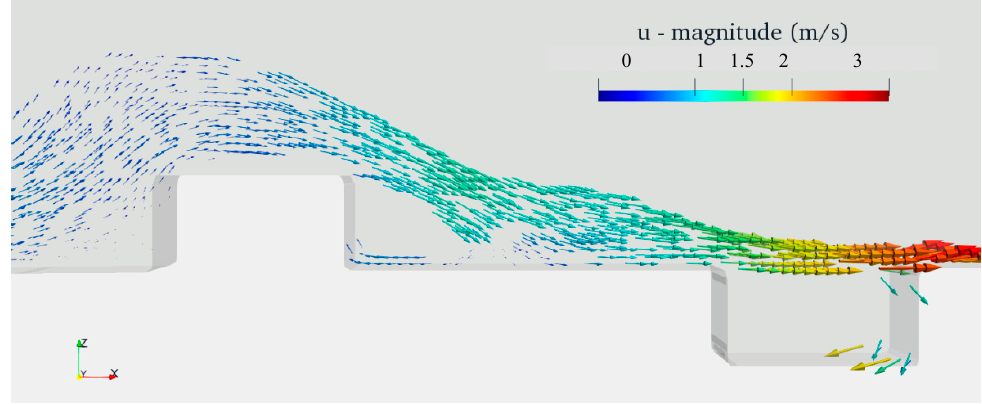
Figure 27. Current velocity vectors at t = 13.2 s for simulation Case 52 (Table 4).